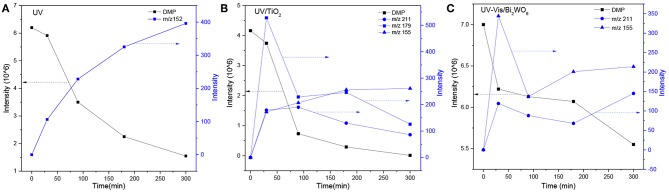
Time-dependent evolution profiles of DMP and its byproducts in different systems (A: UV; B: UV/TiO2; C: UV-Vis/Bi2WO6).